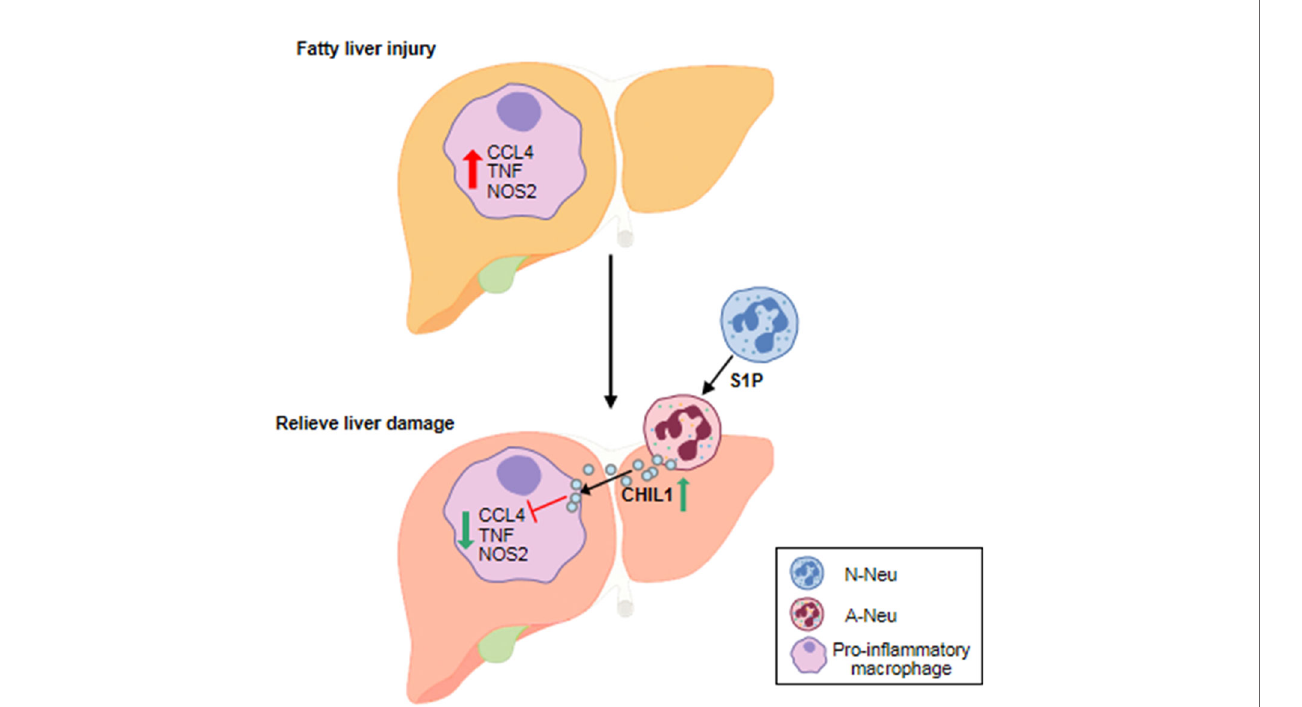
FIGURE 8 | The schematic diagram of the main content of this study. A-Neu secrete CHIL1 and reduce liver in fl ammation by inhibiting the pro-in fl ammatory macrophage response. A-Neu, activated neutrophil; N-Neu, non-activated neutrophil; Ccl4, C-C chemokine motif ligand 4; Tnf, tumor necrosis factor; Nos2, nitric oxide synthase 2; S1P, Sphingosine 1-phosphate; Chil1, Chitinase-like